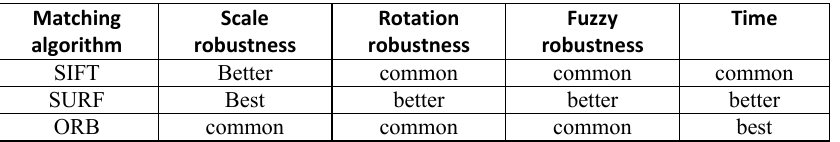
Table 2. Feature matching algorithm analysis.